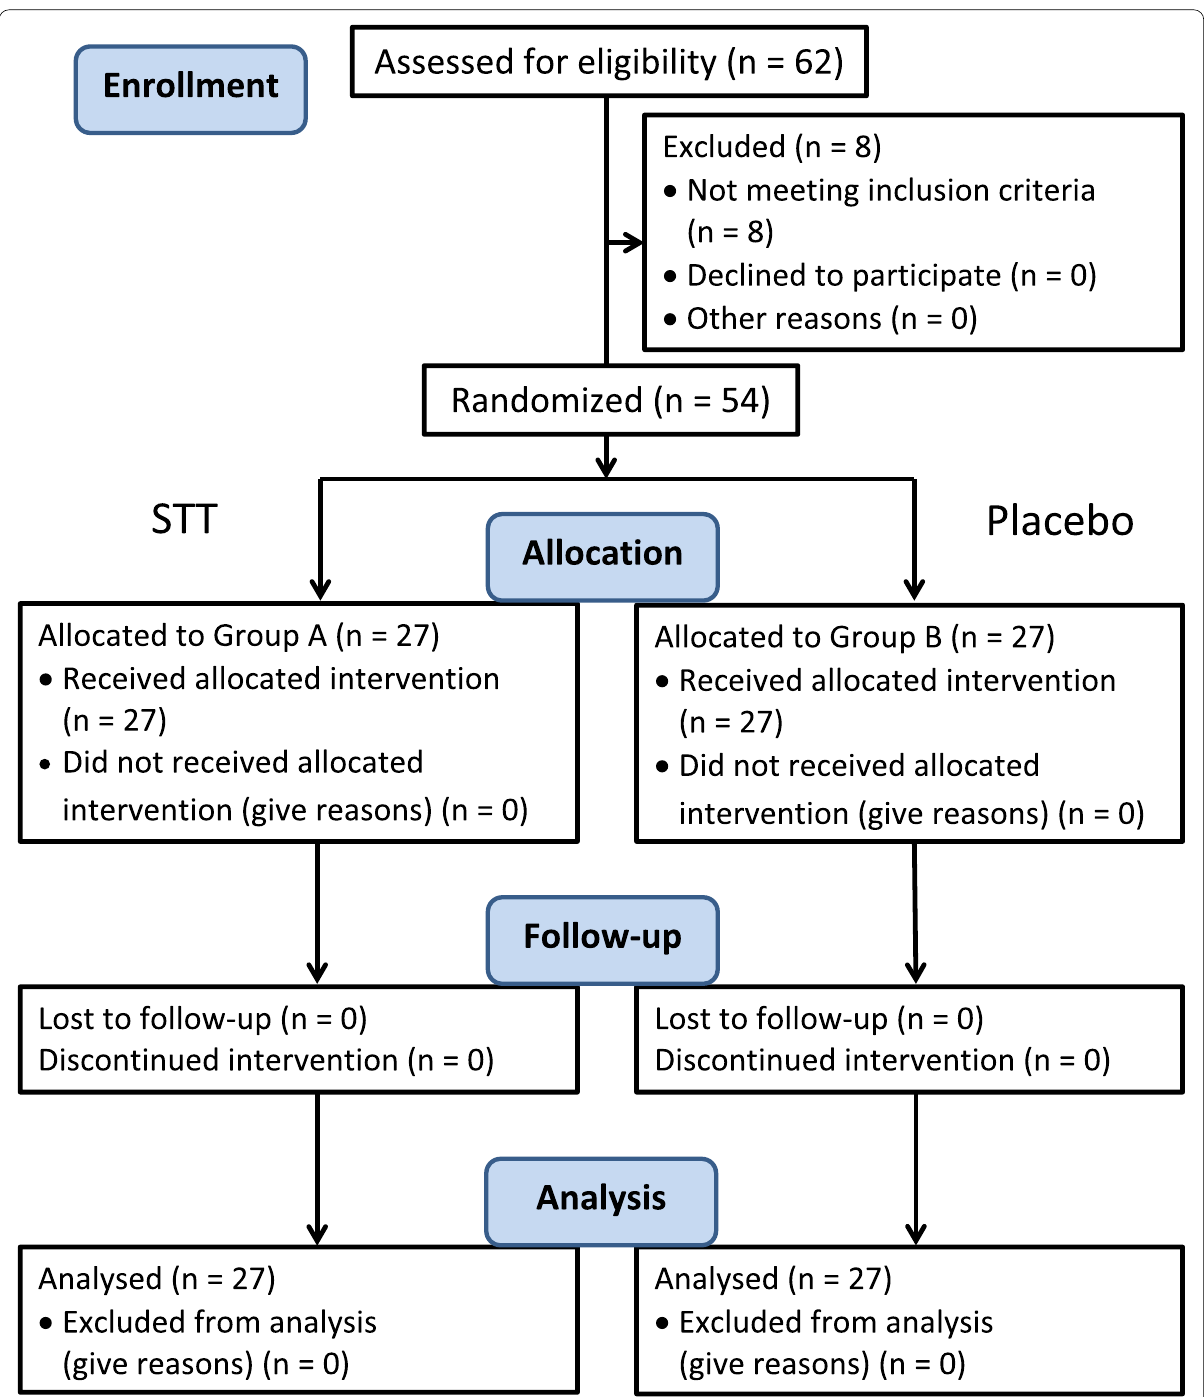
Fig. 1 Consolidated Standards of Reporting Trials (CONSORT) flow